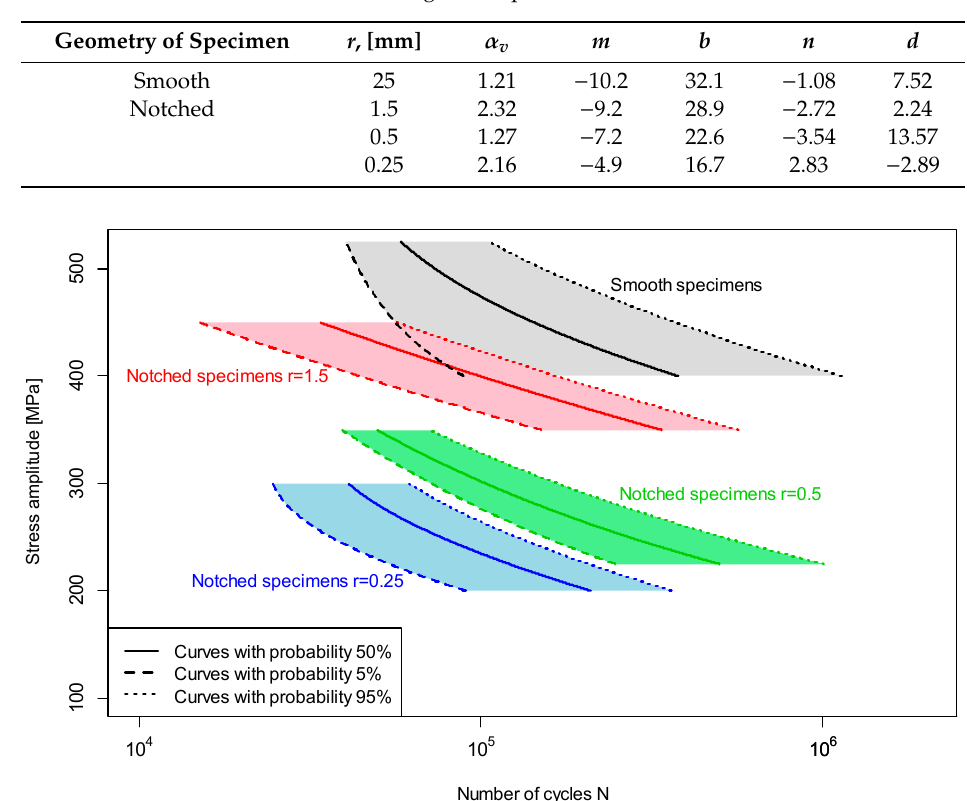
Table 4. Value of linear regression parameters for the 1.4301 steel.